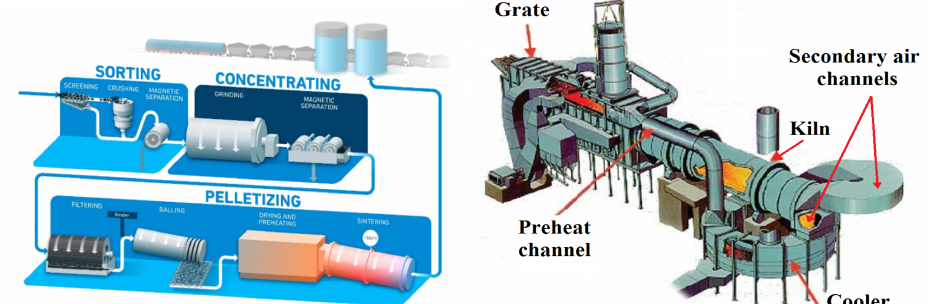
Figure 1. Production of iron ore pellets, process overview to the left, and grate–kiln indurating machine to the right. Courtesy of Luossavaara-Kiirunavaara Aktiebolag